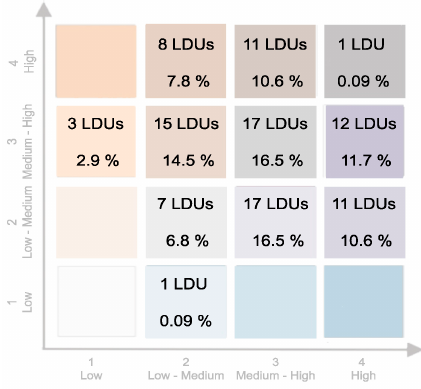
Figure 21. Number of LDUs per value of risk of loss of landscape value.